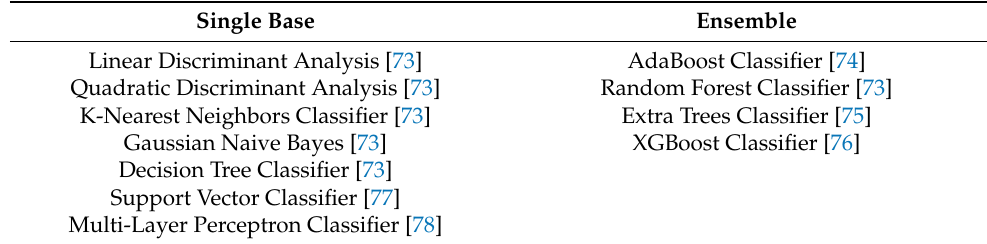
Table 4. Different classifier models used to learn and define a pipeline with the nomenclature proposed by Ma et al.